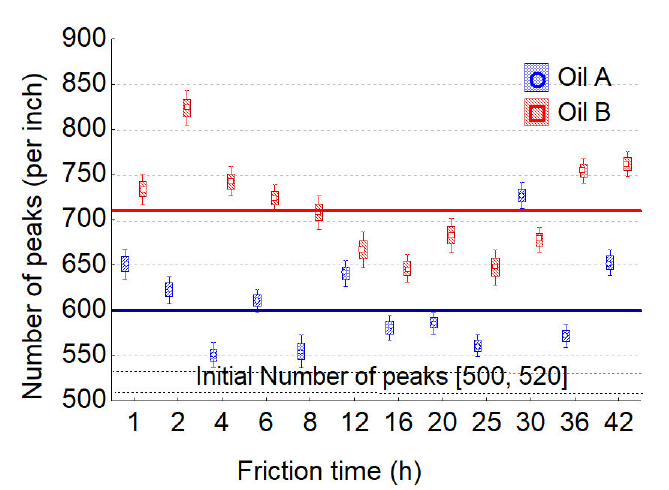
Figure 16. Plot of the relevance function F and their associated interactions corresponding to the 2D roughness parameters.